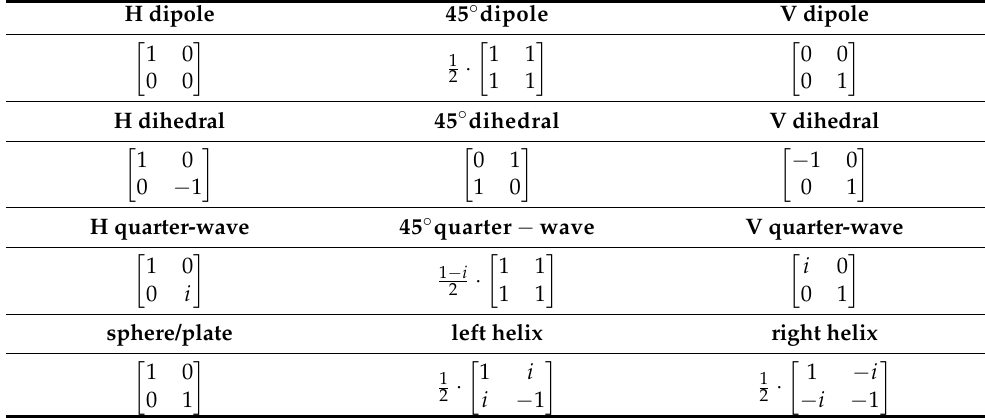
Table 1. Monostatic scattering matrices of elementary targets in HV basis.